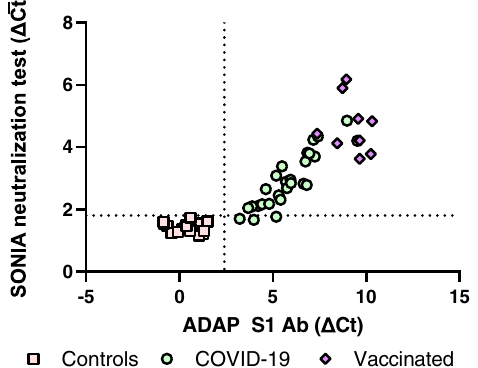
Fig. 6 Analysis of neutralizing antibodies in at-home collected dried blood spot specimens. Dried blood spot specimens from convalescent COVID-19 patients ( n = 27, green circle), vaccinated ( n = 9, purple diamond) and controls ( n = 20, pink square) were analyzed by the SONIA neutralization PCR test for NAb. The y-axis is the SONIA neutralization PCR test signal Δ Ct calculated by subtracting the Ct value of the sample from that of a buffer only blank control. The same samples were also analyzed for total spike (S1) antibodies with a previously reported method and plotted in the x-axis. The x-axis is the ADAP assay signals Δ Ct calculated by subtracting the buffer only blank control Ct from the Ct value of the sample 22